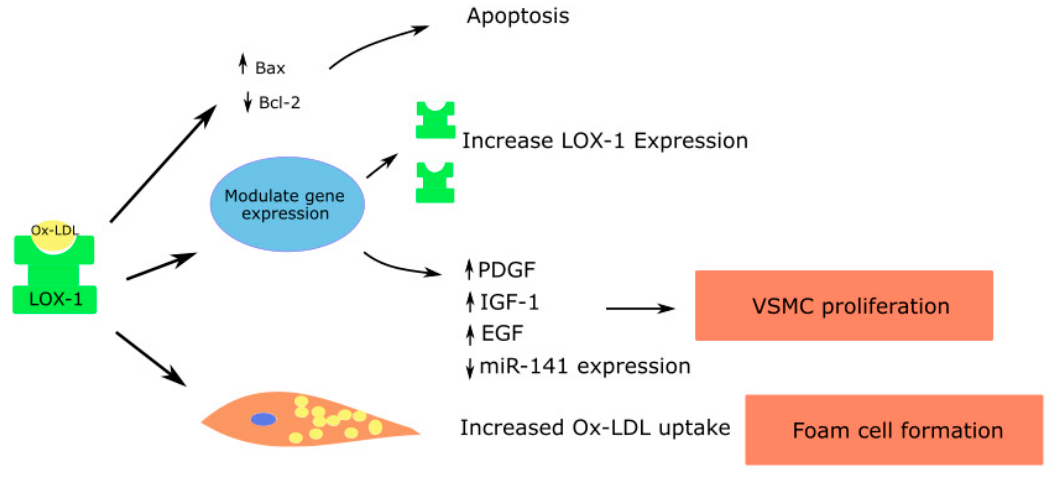
Figure 3. Role of LOX-1 in vascular smooth muscle cells contributing to atherosclerosis; Platelet derived growth factor—PDGF; Insulin like growth factor—IGF; Epidermal growth factor—EGF.